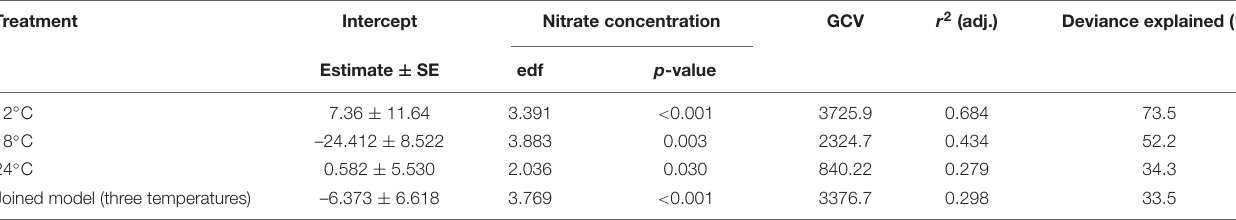
TABLE 2 | Generalized additive model (GAM) results.